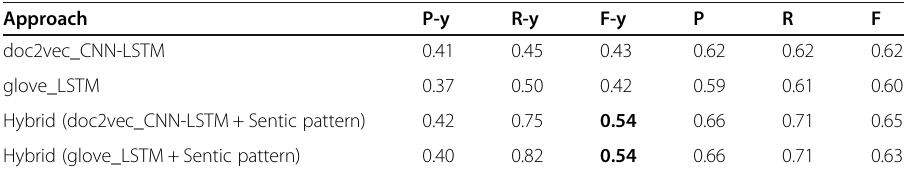
Table 7 Results of various approaches considering performance for both identifying doubt and overall doubt classification ( P, R, F denotes Precision, Recall, and F1 score, respectively, with P-y indicating Precision in identifying doubt or label ‘ y ’ during testing ) Approach P-y R-y F-y